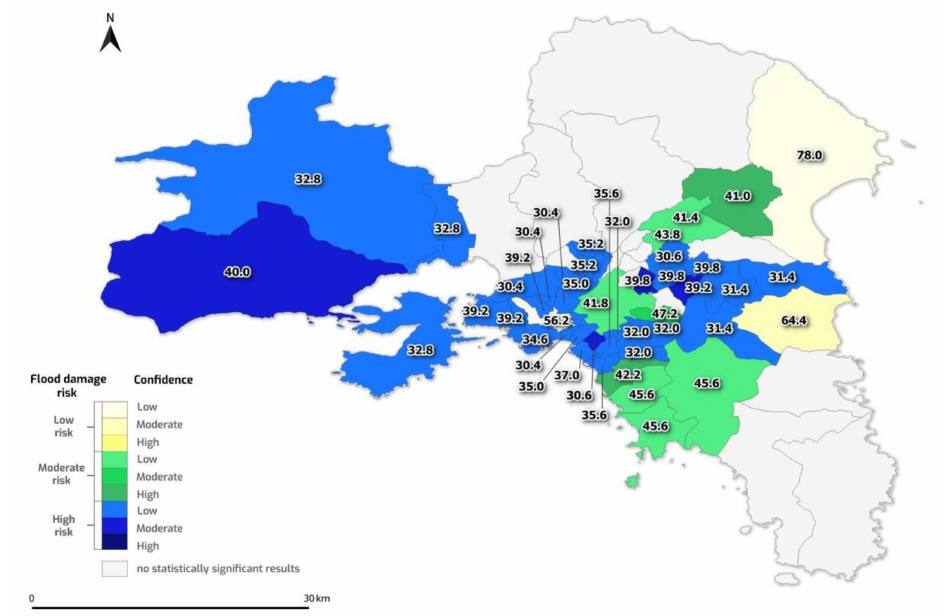
Figure 5. Optimal R24 thresholds (mm) above which flood damage is likely to occur, level of flood damage risk (3-color palette), and level of confidence in R24’s discriminating performance, at the municipality